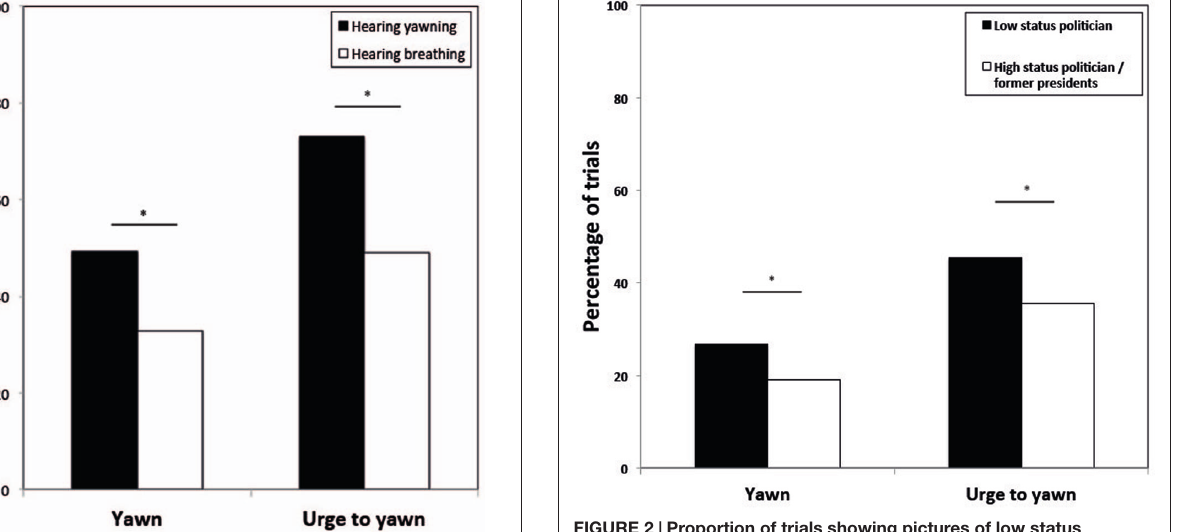
FIGURE 1 | Proportion of participants that responded with a yawn or had the urge to yawn while/after hearing either yawns (experimental condition, black bars) or breaths (control, white bars). * p < 0.05.